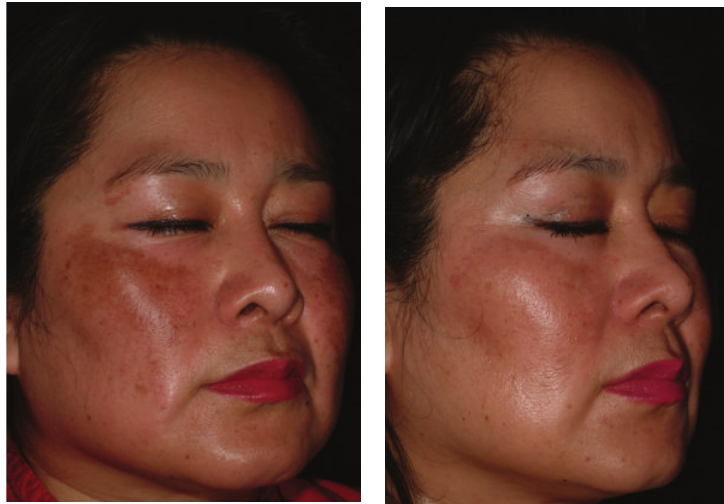
Figure 1: Right side treated with niacinamide. View at onset and 8 weeks later with an excellent decrease in pigmentation.